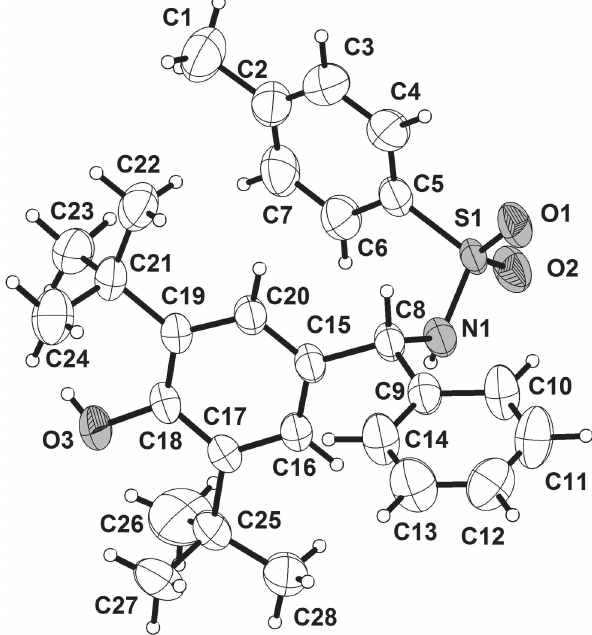
Table 1: Data collection and